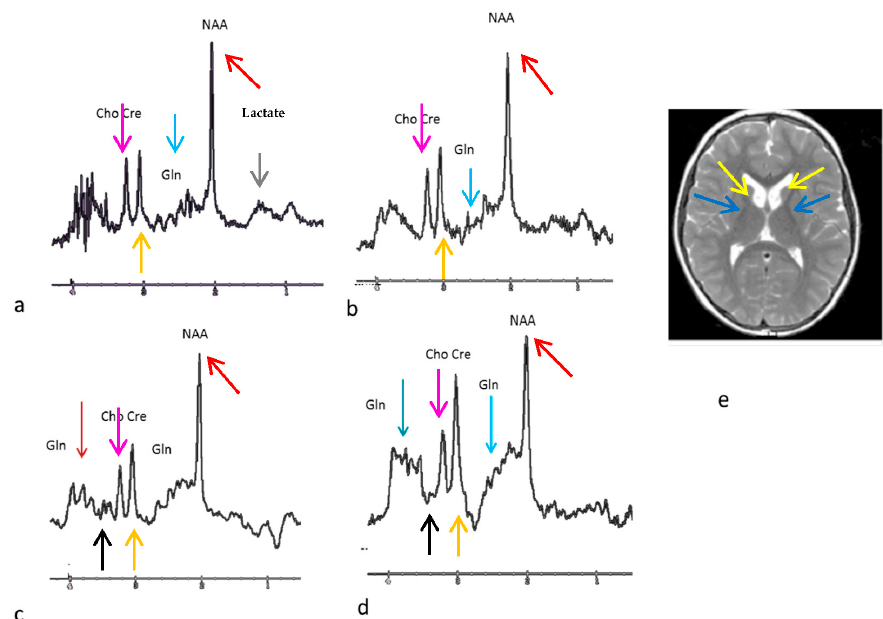
Figure 4 . Voxel locations include left parietal white matter on 3 October 2008 ( a ) and on 18 November 2008 ( c ) and left basal ganglia on 3 October 2008 ( b ) and on 18 November 2008 ( d ) following HA episodes. Glutamine/Glutamate (blue arrow shows beta and gamma proton; green and brown arrows show the alpha proton), N -acetylaspartate (NAA) (red arrow), myoinositol (black), choline (purple), and creatine (orange) peak heights are shown. Elevated glutamine peaks are apparent in 4b - 4d . 4a depicts mildly elevated lactate (gray) and decreased myoinositol peaks. Decreased myoinositol (essentially undetectable on the panels; the arrow shows the location of where the peak resonates) and choline peaks can be seen in 4c . A notably decreased NAA peak in the basal ganglia is shown in 4d . 4e : Axial MR image on 18 November 2008 through the basal ganglia demonstrating normal brain signal on the T2-weighted image. Mild striatal atrophy is present with volume loss involving the caudate (yellow arrows) and lentiform nuclei (blue arrows). The MRS on 3 October 2008 was done shortly after a hyperammonemic event (HA). The MRI on 11/08/2008 was performed after resolution of HA. Here are some of the ammonia levels from the preceding days (all in µmol/L) (Table 1). Table 1. The ammonia levels from the preceding days (all in µmol/L).